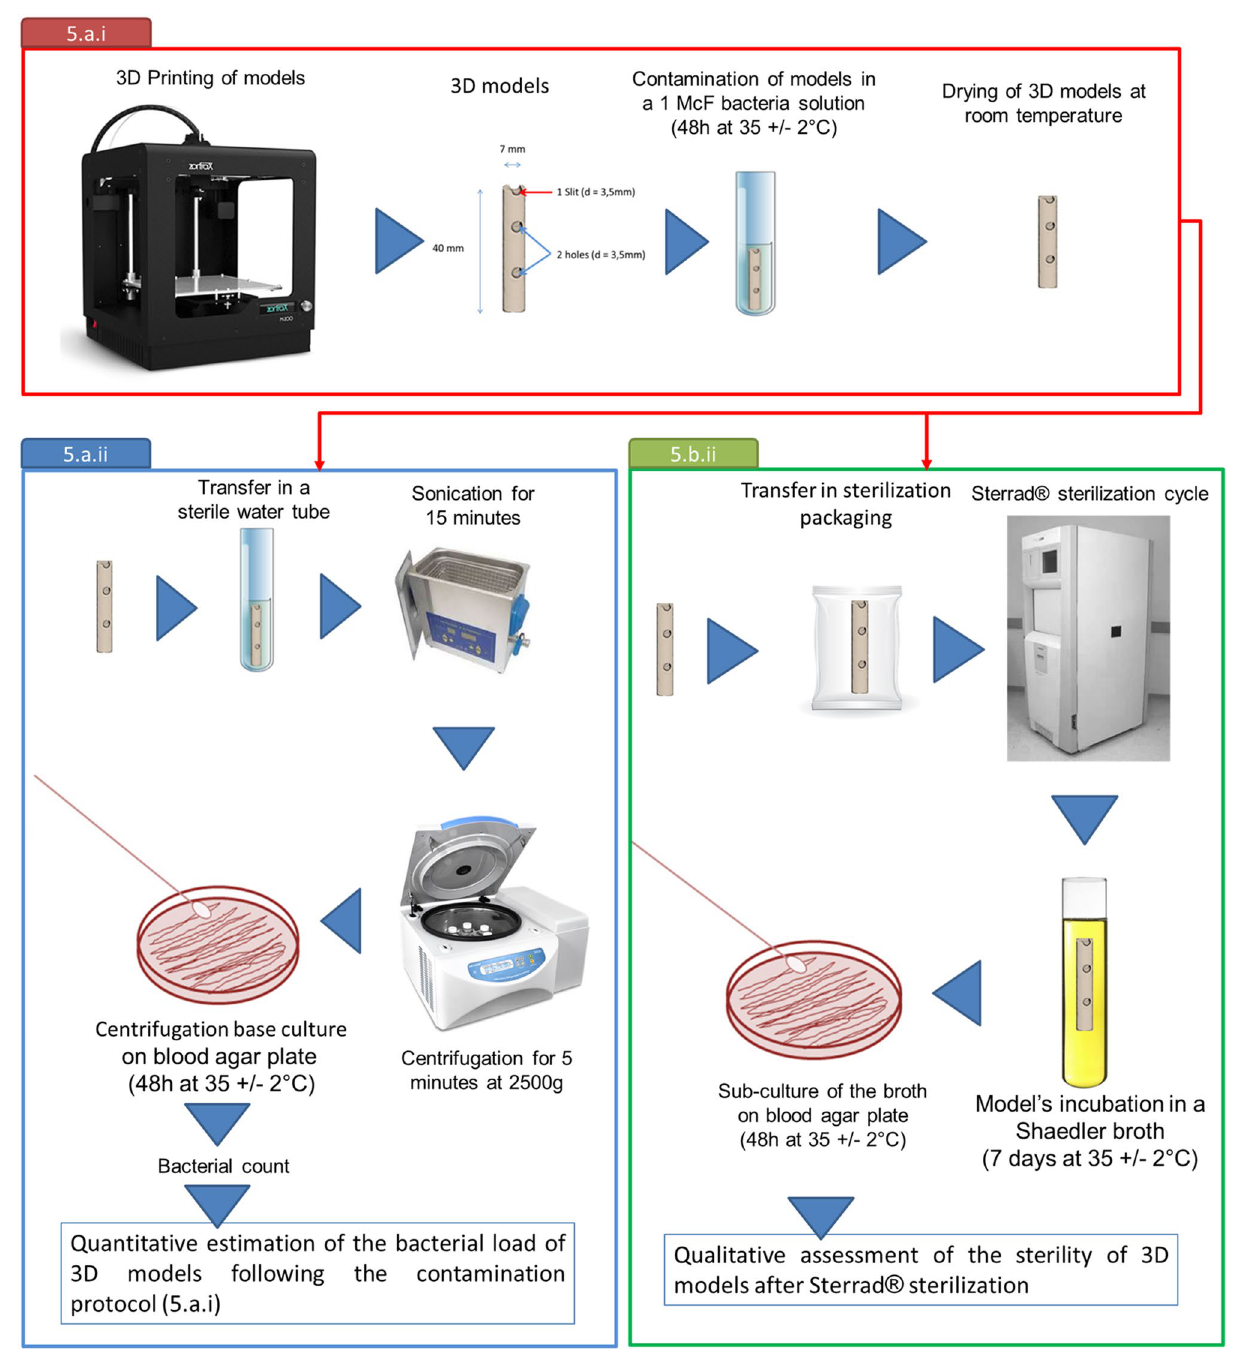
Figure 2. Steps of the in-house to assess the effectiveness of Sterrad’s sterilization